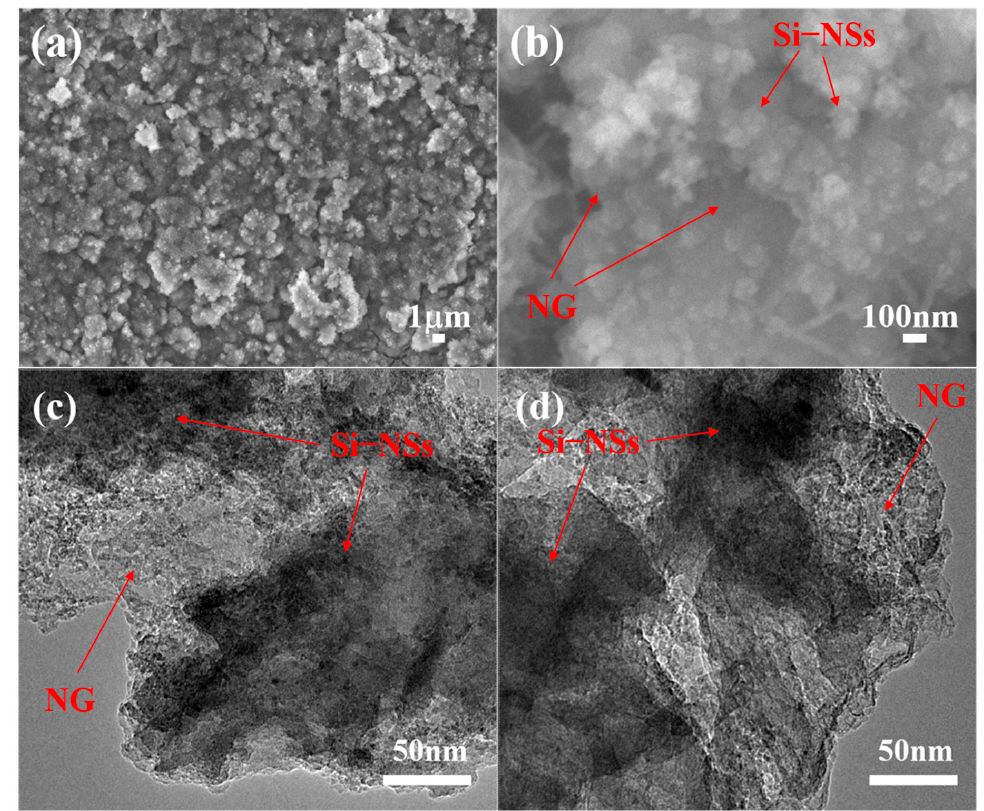
Figure 8. ( a , b ) SEM images of Si–NSs@C/NG electrode after 120 cycles; ( c , d ) TEM images of Si– NSs@C/NG electrode after 120 cycles.